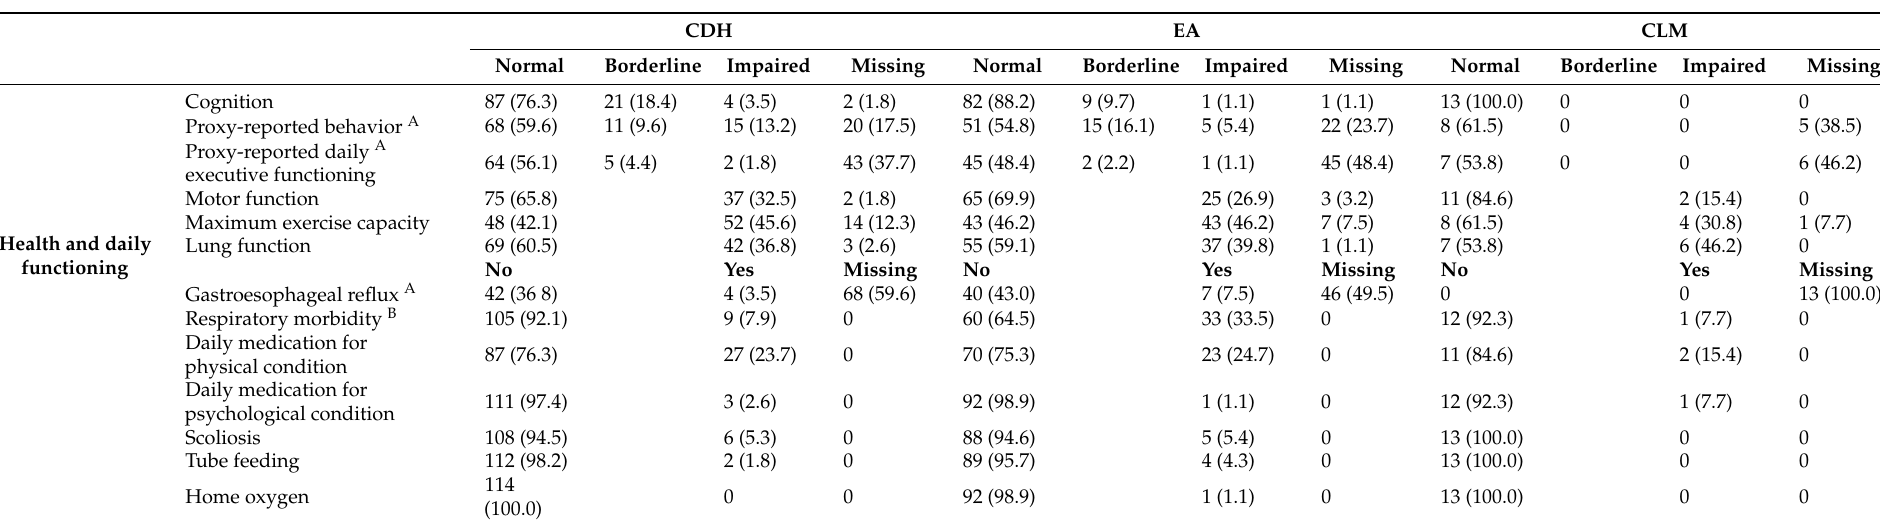
Table 2. Clinical outcomes of 8-year-old children with congenital diaphragmatic hernia (CDH, n = 114), esophageal atresia (EA, n = 93), and congenital lung malformation (CLM, n = 13), summarized per clinical domain. Data are presented as n (% of total cohort). Cognition, proxy-reported behavior, and proxy-reported daily executive functioning were categorized as normal, borderline, or impaired. All other clinical domains were categorized as either normal or impaired, or as yes or no. See the Methods section and the Supplementary Materials for a detailed description of the administered